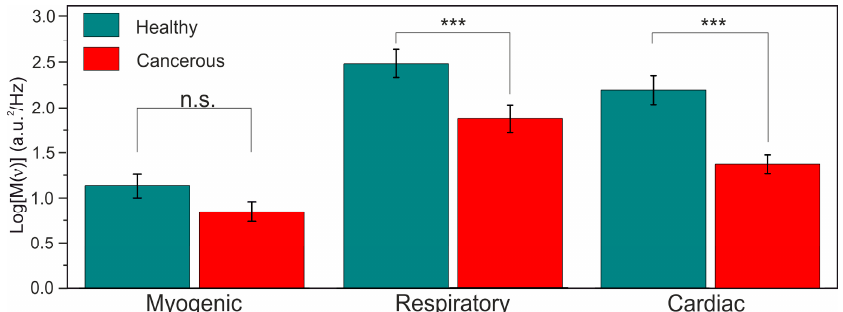
Figure 6. Results on the statistical analysis (One-Way ANOVA with Tukey’s post hoc test, *** p < 0.001, n.s.: not significant, Mean ± SE) of the differences in the oscillations in normal intact and cancerous tissues in the hepatoduodenal area.